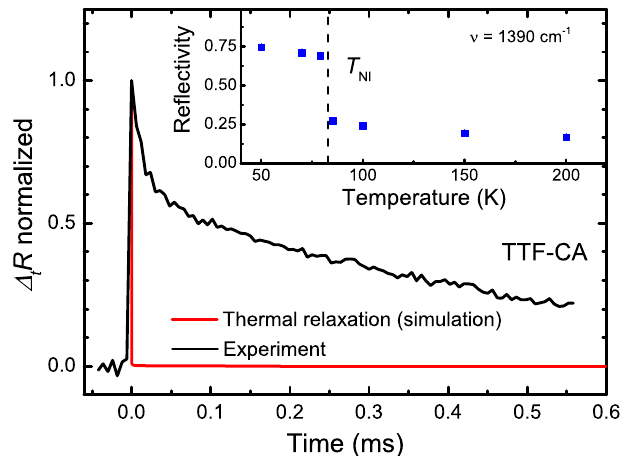
Figure 28. Comparison of the thermally-induced reflectivity change ∆ t R (red) with the observed photo-induced reflectivity change (black). Their decay characteristics are completely different from each other. In the inset, the reflectivity of the ν 3 mode at 1390 cm − 1 is displayed as a function of temperature. The reflectivity jumps at T NI due to the enhanced infrared intensity of the emv-coupled mode in the ionic state (after